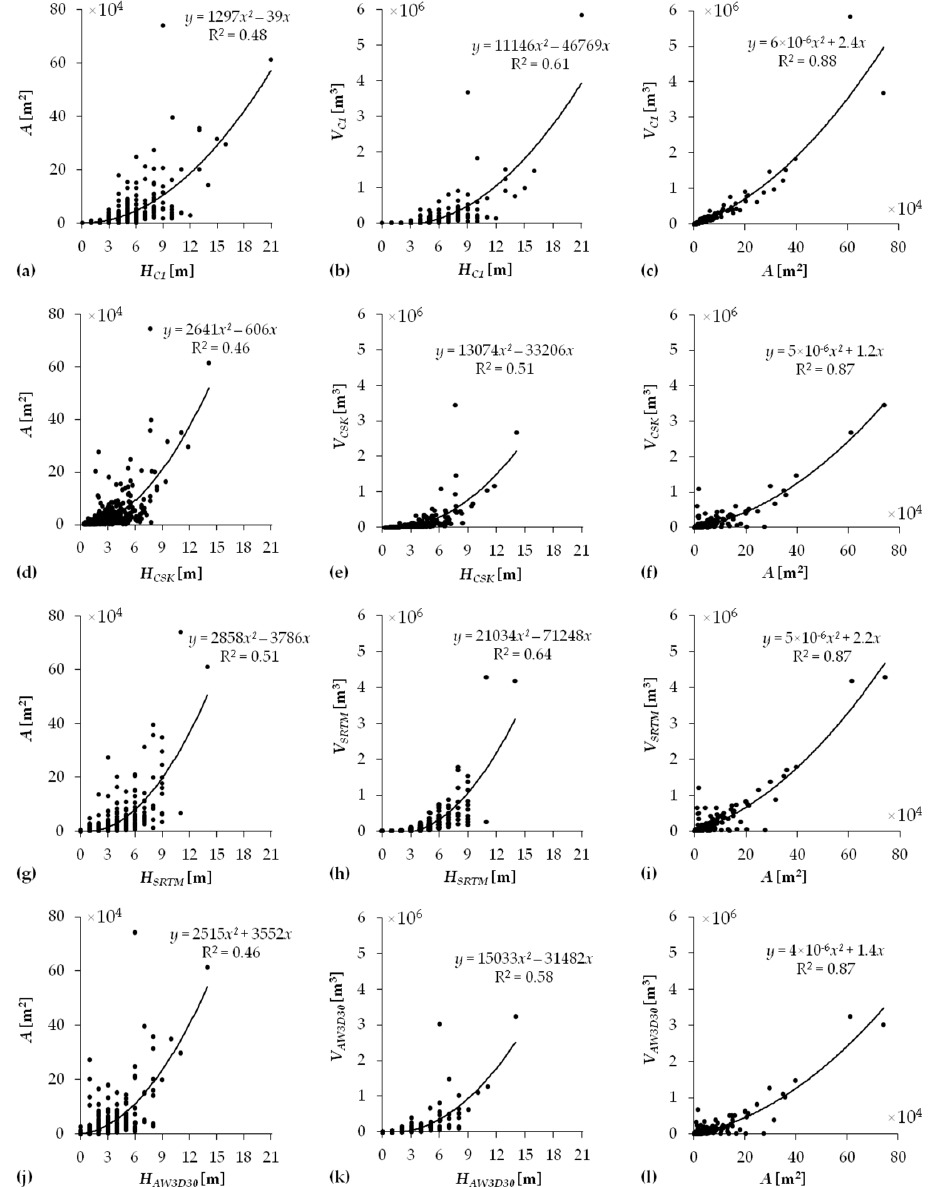
Figure 9. Relationships between height ( H i ), area ( A ) and volume ( V i ), for: ( a – c ) CartoSat-1 DSM, and ( d – f ) COSMO-SkyMed, ( g – i ) SRTM and ( j – l ) AW3D30 DEMs.